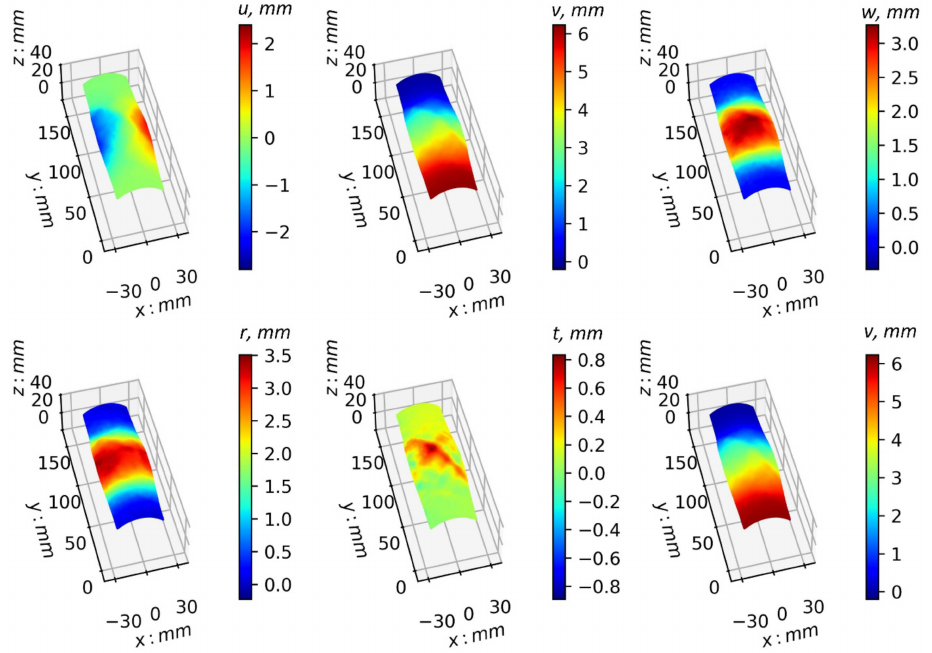
Figure 2. First row is displacement fields of test 092903b between axial strain 3.2% and 7.0%; left to right are displacements along horizontal ( u ), vertical ( v ), and out-of-plane ( w ) directions based on a spatial coordinate system. Second row is the same displacement field, but decomposed into radial ( r ), tangential ( t ), and vertical ( v ) directions on cylindrical